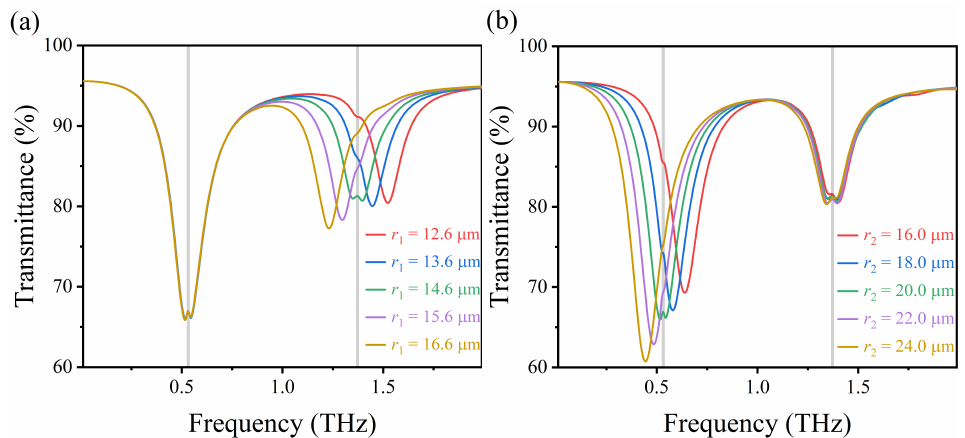
Figure 7. ( a , b ) Transmission spectra of AIGS covered with lactose at different arc radii r 1 and r 2 under vertically incident TM waves.